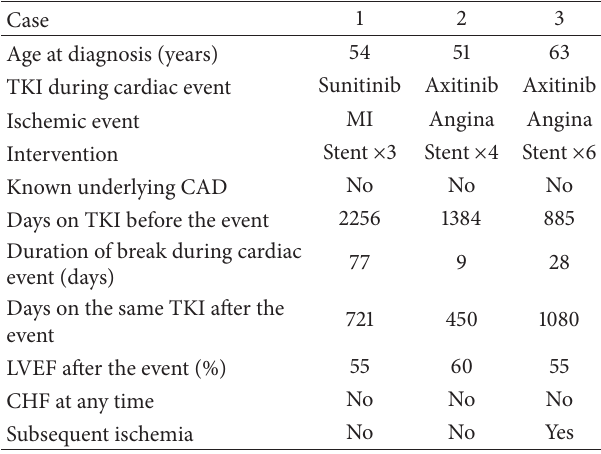
Table 1: Summary of ischemic events and interventions on anti- VEGF